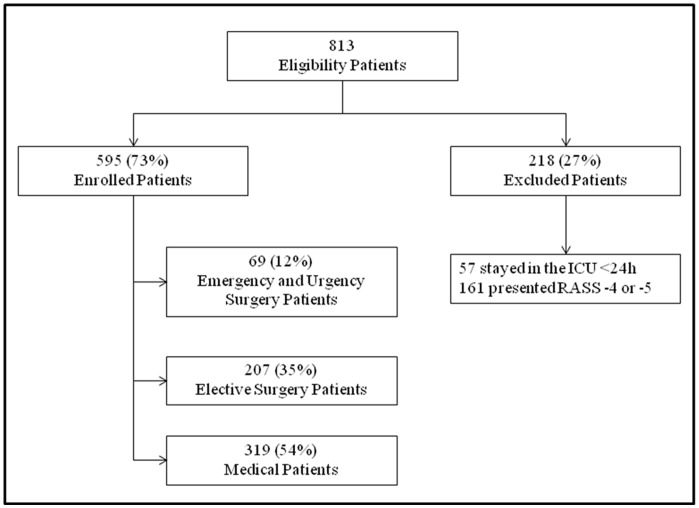
Flowchart of patients in study.ICU = Intensive Care Unit.